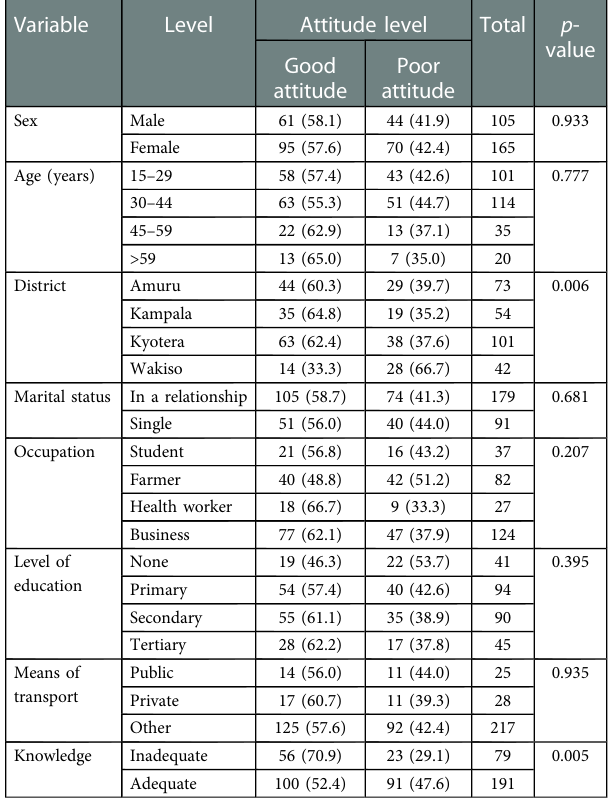
TABLE 5 The association between attitudes and demographic characteristics of the respondents. Variable